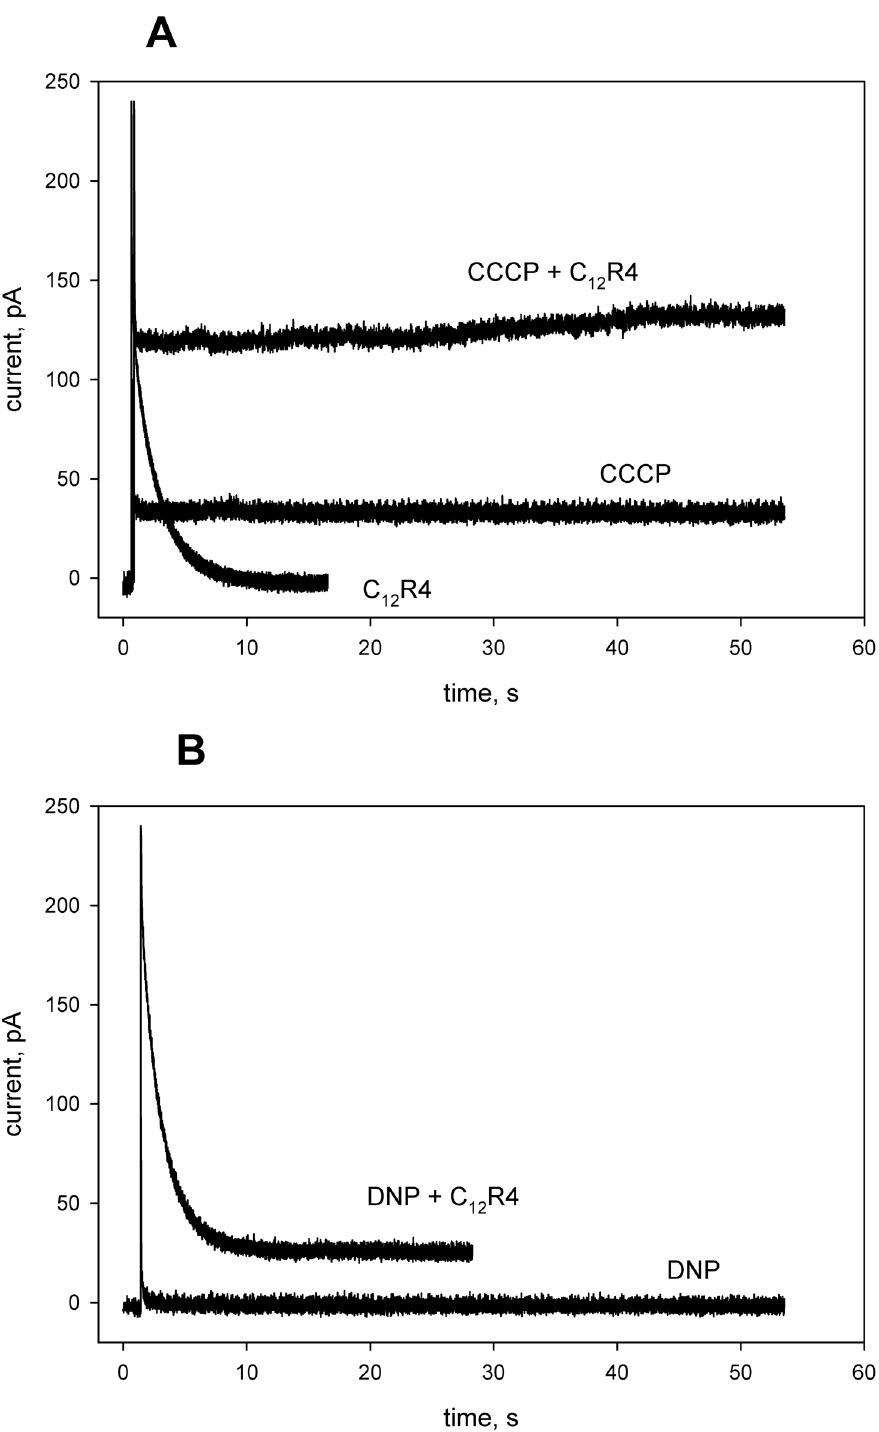
Figure 3. C 12 R4 (rhodamine B dodecyl ester) strongly increases CCCP- (panel A) or DNP-mediated (panel B) electric current through bilayer lipid membrane (BLM). Where indicated, 0.1 m M CCCP or 1 m M DNP were added to both compartments prior to the measurements; incubation mixture, 0.1 M KCl, 10 mM Tris, 10 mM MES, pH 7.0; at t=1.5 s, 100 mV voltage was applied to the BLM. Concentration of C 12 R4 was 0.1 m M.